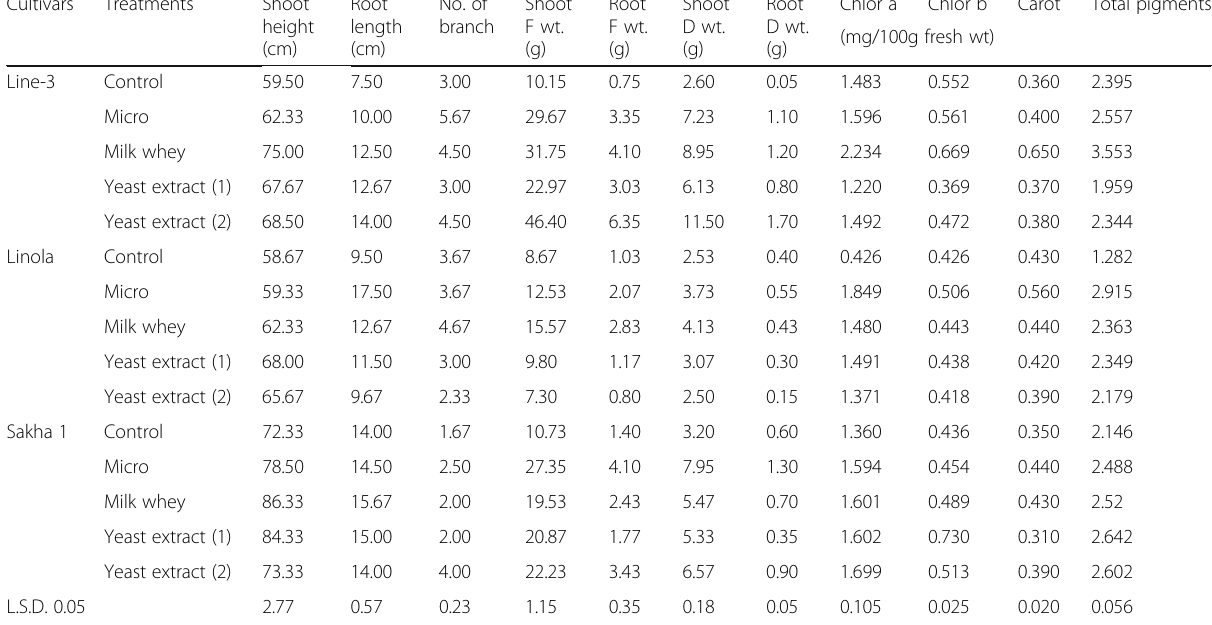
Table 7 Effect of interaction between flax cultivars and bio-fertilizer treatments Cultivars